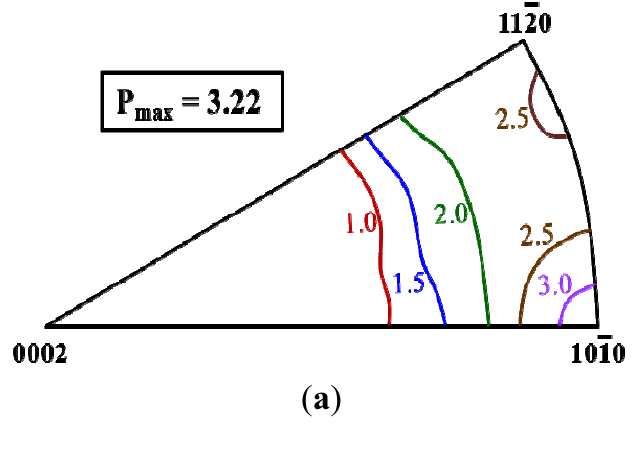
Figure 2. Inverse pole figures recorded on the plane perpendicular, and the mid-plane parallel to the extrusion direction of AZ31 rod extruded at: ( a ) 300 °C; ( b ) 350 °C; and ( c ) 450 °C.